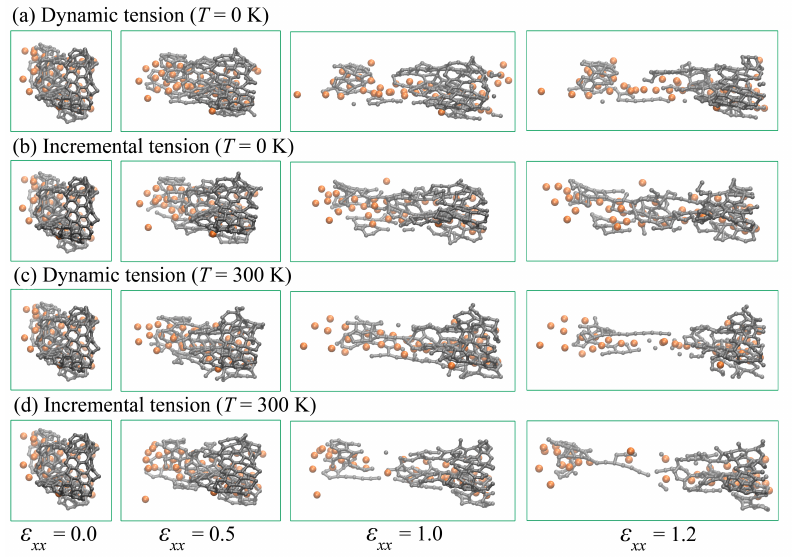
Figure 10. Snapshots of a single structural element of a Ni/graphene composite under dynamic ( a , c ) and incremental ( b , d ) uniaxial tension at 0 ( a , b ) and 300 K ( c , d ). Strain rate is ˙ ε = 5 × 10 − 3 ps − 1 . Colors as in Figure